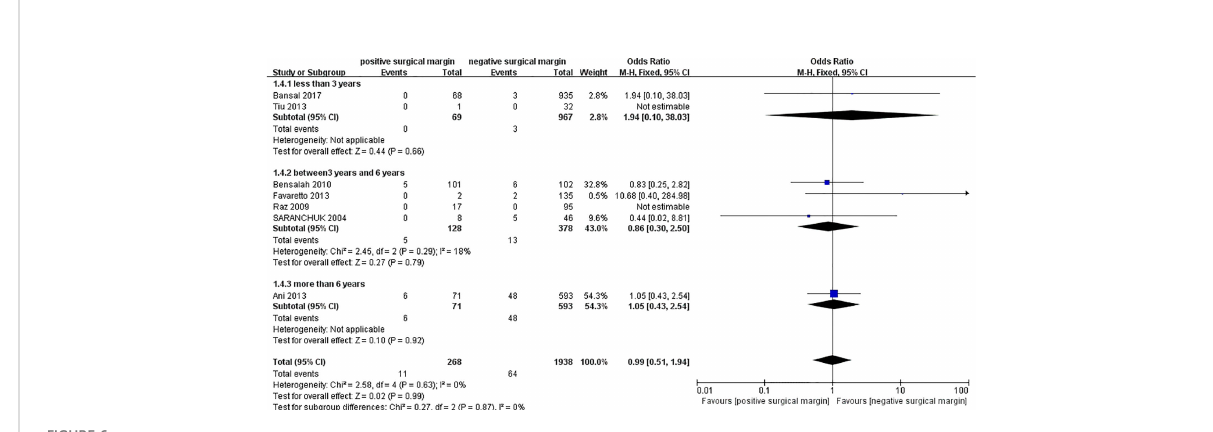
FIGURE 6 Comparison of cancer speci fi c death between PSM and NSM